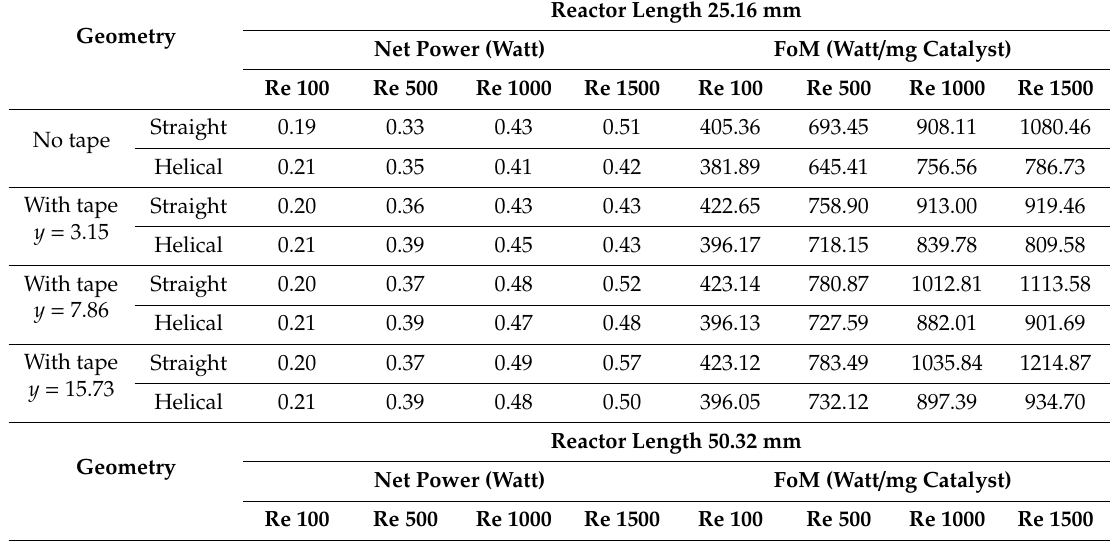
Table 2. Net power generation from methane combustion (in Watt) and Figure of Merit (FoM) for a single channel VAM reactor (in W / mg